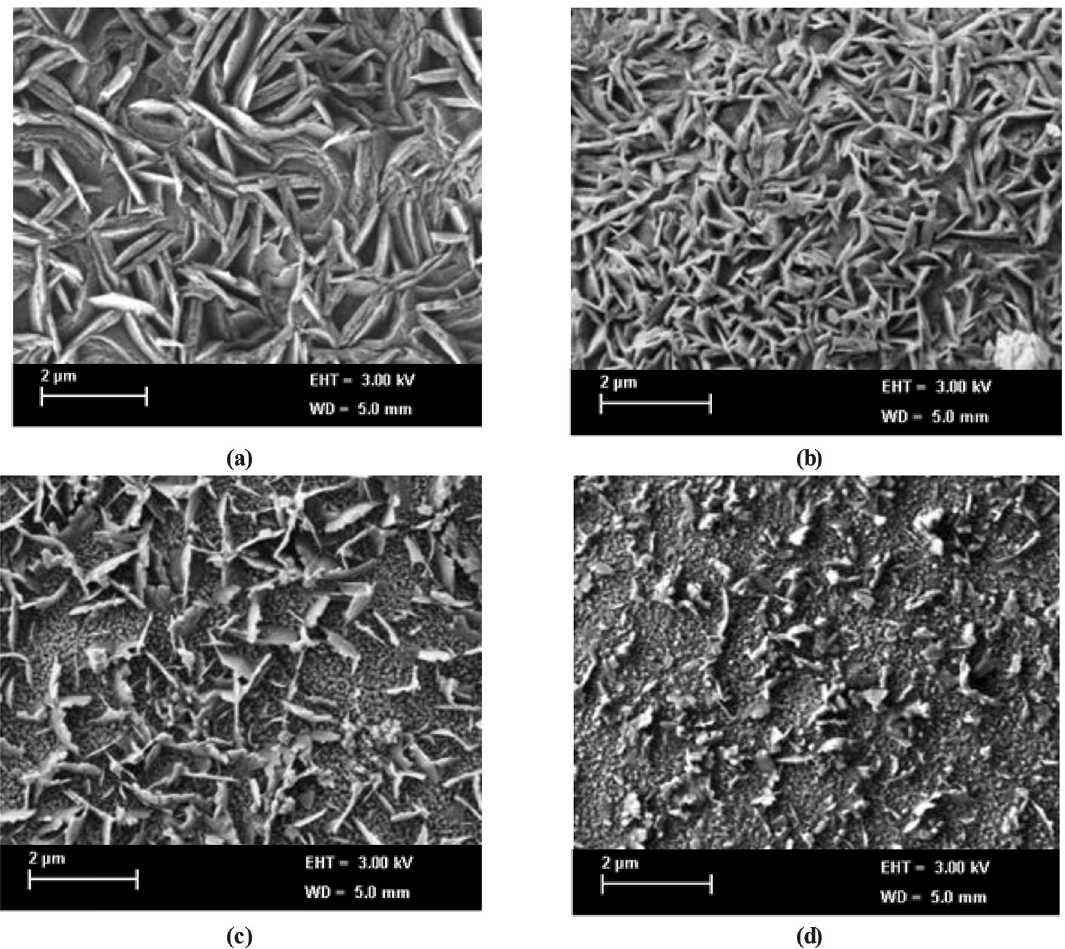
Figure 6. FSEM images of Mg–Zn ferrite nano powder ( a ) Mg 20 , ( b ) Mg 40 , ( c ) Mg 60, and ( d ) Mg 80